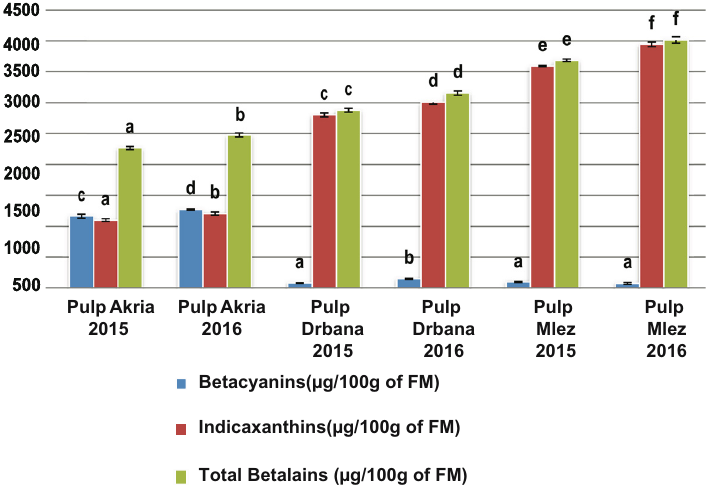
Figure 7: Betalain content ( betacyanins, indicaxanthins, and total betalains ) of the fruit pulp of the discussed varieties ( Akria, Drbana, and Mlez ) produced in both 2015 and 2016 crop years. Mean values with the same letter did not present a signi fi cant di ff erence at p <